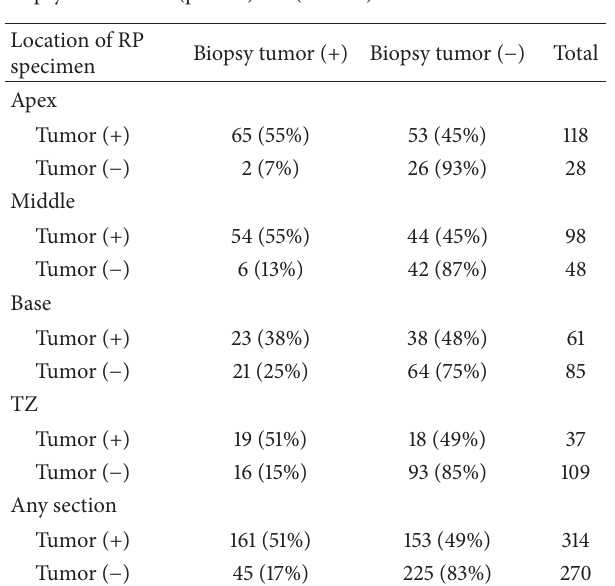
Table 3: Concordance rate of prostatectomy specimen and needle biopsy. 𝑛 = 584 . 73 (patient) × 8